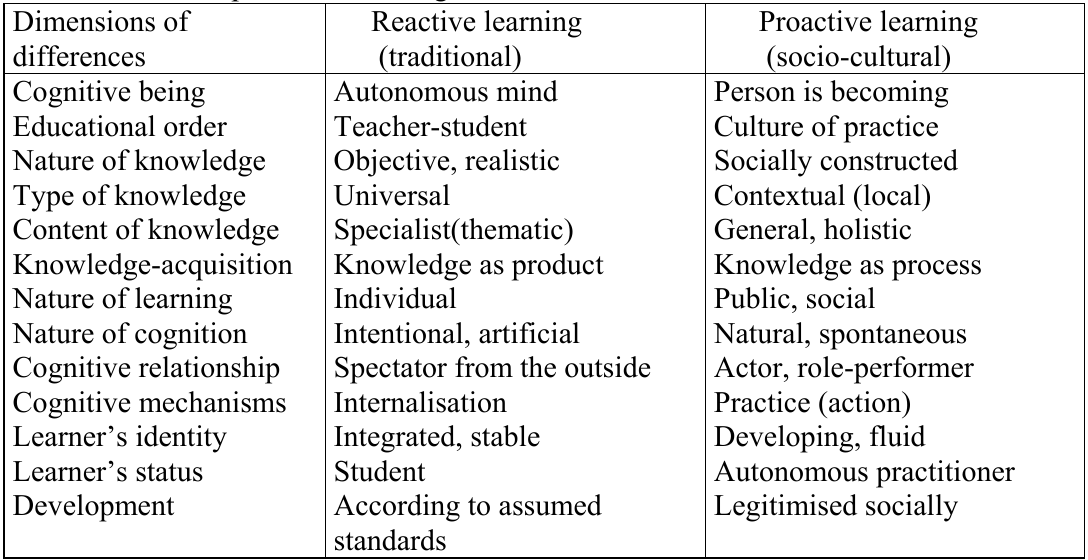
Table 1 . Reactive/proactive learning Dimensions of